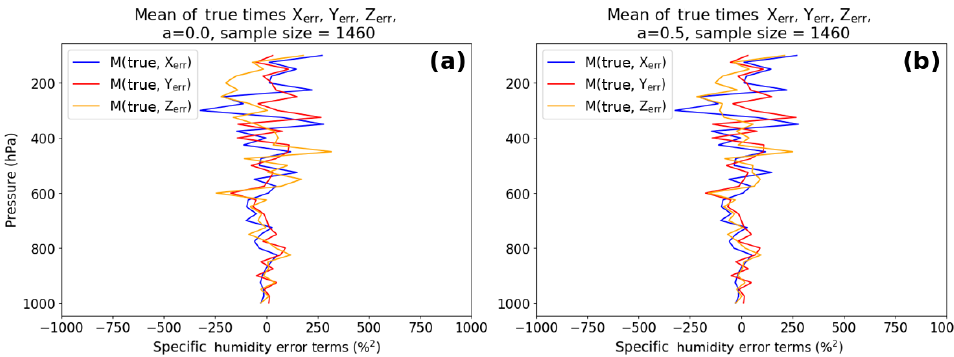
Figure 6. Mean of products of true and X err , Y err and Z err for (a) a = 0 and (b) a = 0 . 5. All error terms are